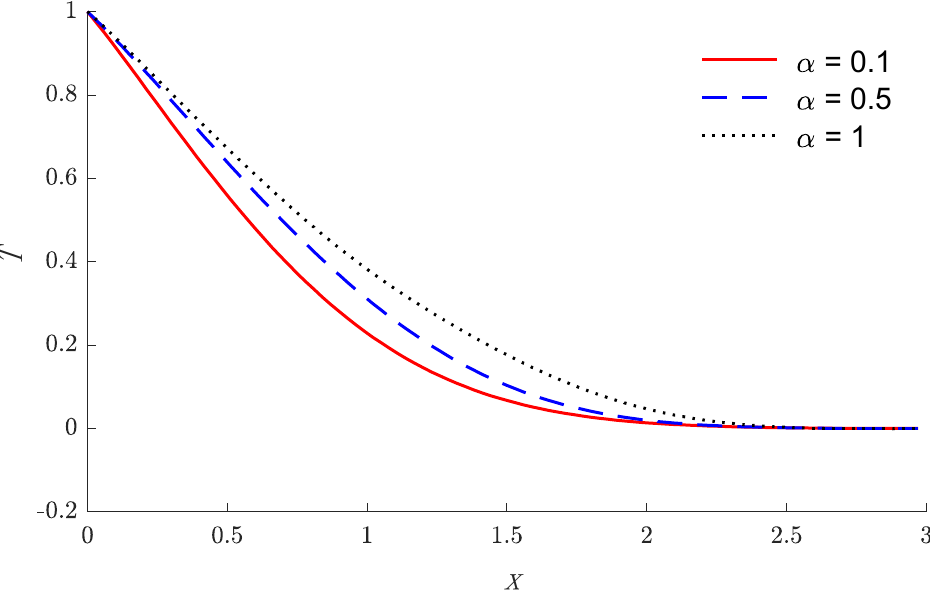
Figure 1. The temperature distributions via the distance x for three values of fractional parameter. When τ o = 0.05: